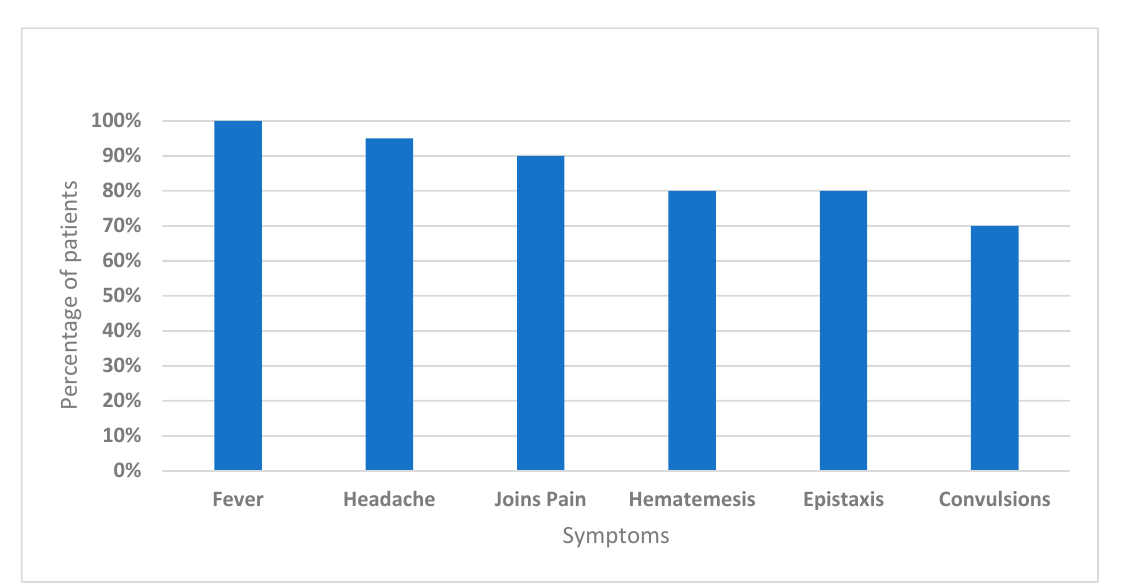
Figure 3. Number of Crimean-Congo hemorrhagic fever (CCHF) cases reported during each epi- demic per state .